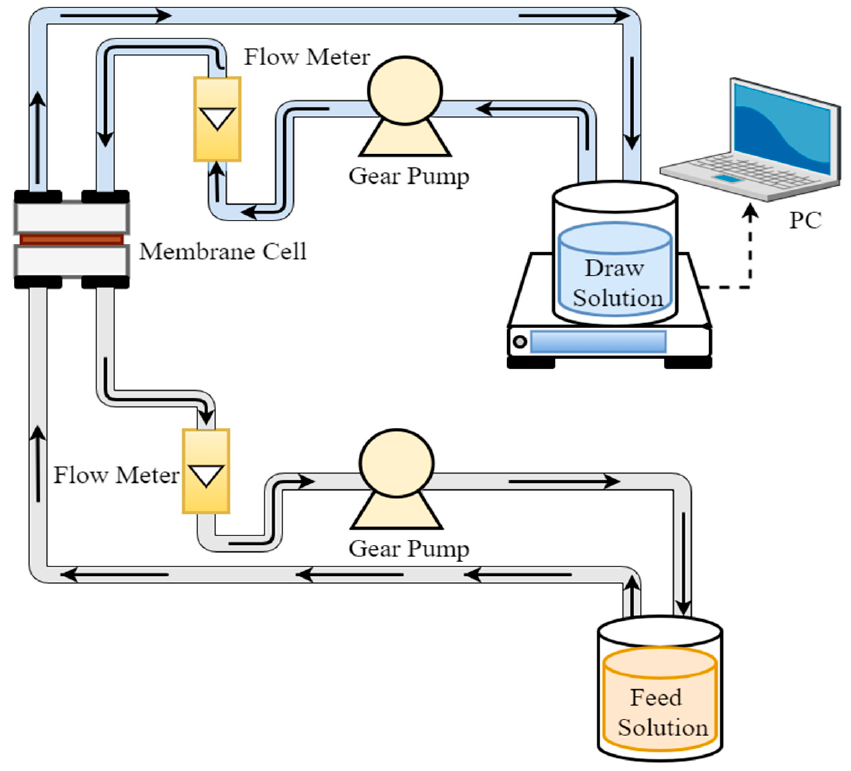
Figure 2. Schematic of a typical bench-scale FO system. The FO permeate was separated from the draw solution using the RO process. The same Sterlitech membrane filtration system was used for RO with proper pressure setup. The RO was run in the crossflow mode at the 6.0-L/min flow rate and 2895 kPa pressure.